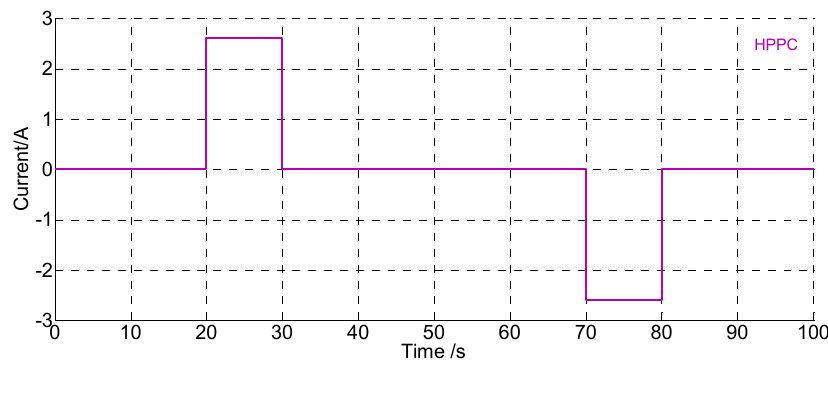
Figure 7. Comparison of voltage responses.